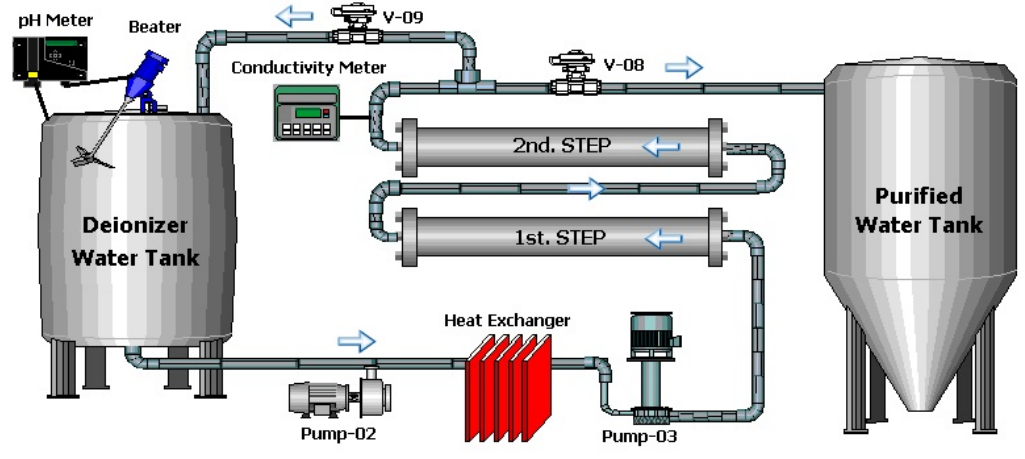
Figure 4. Reverse osmosis